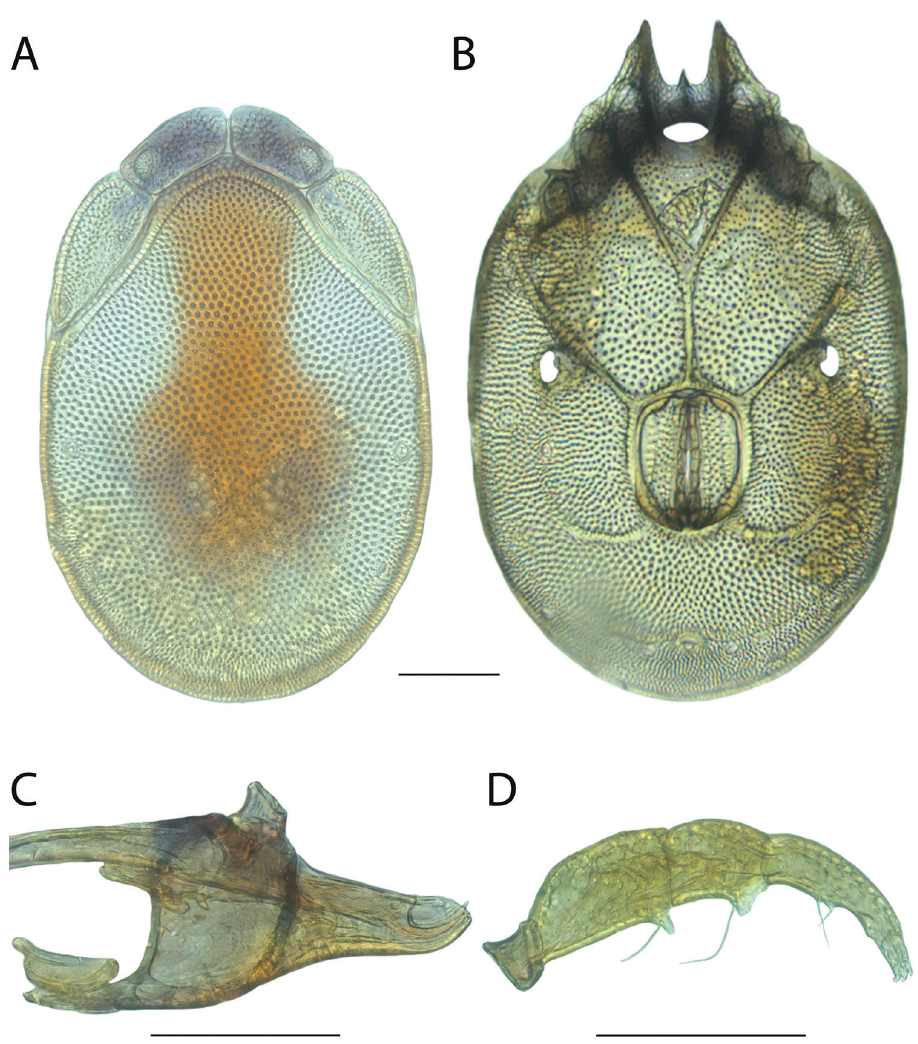
Figure 128. Torrenticola larvata male: A dorsal plates B venter (legs removed) C subcapitulum D pedipalp (setae not accurately depicted). Scale = 100